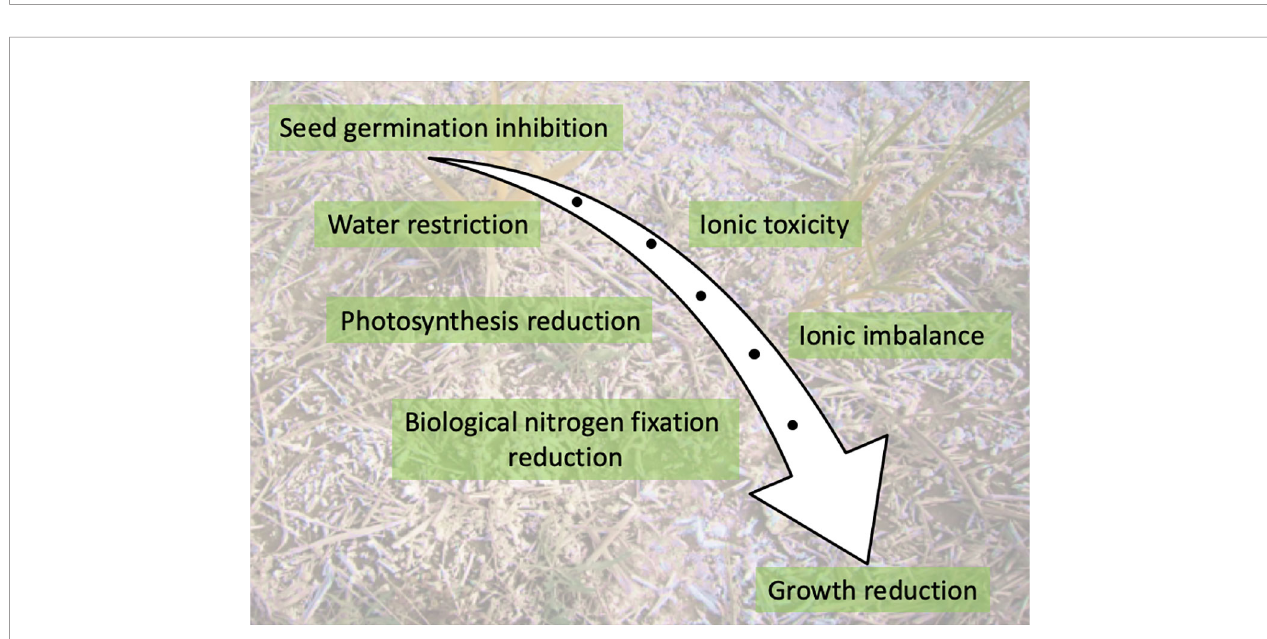
FIGURE 2 | Key impacts of salinity on a developing